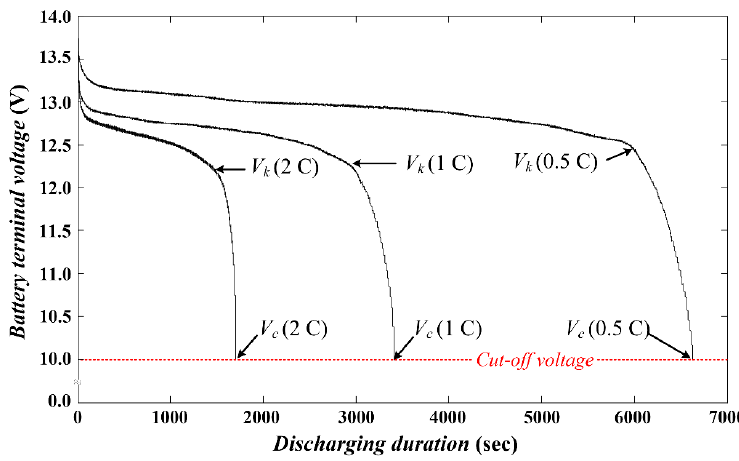
Figure 3. Battery voltage curves with different discharging currents.